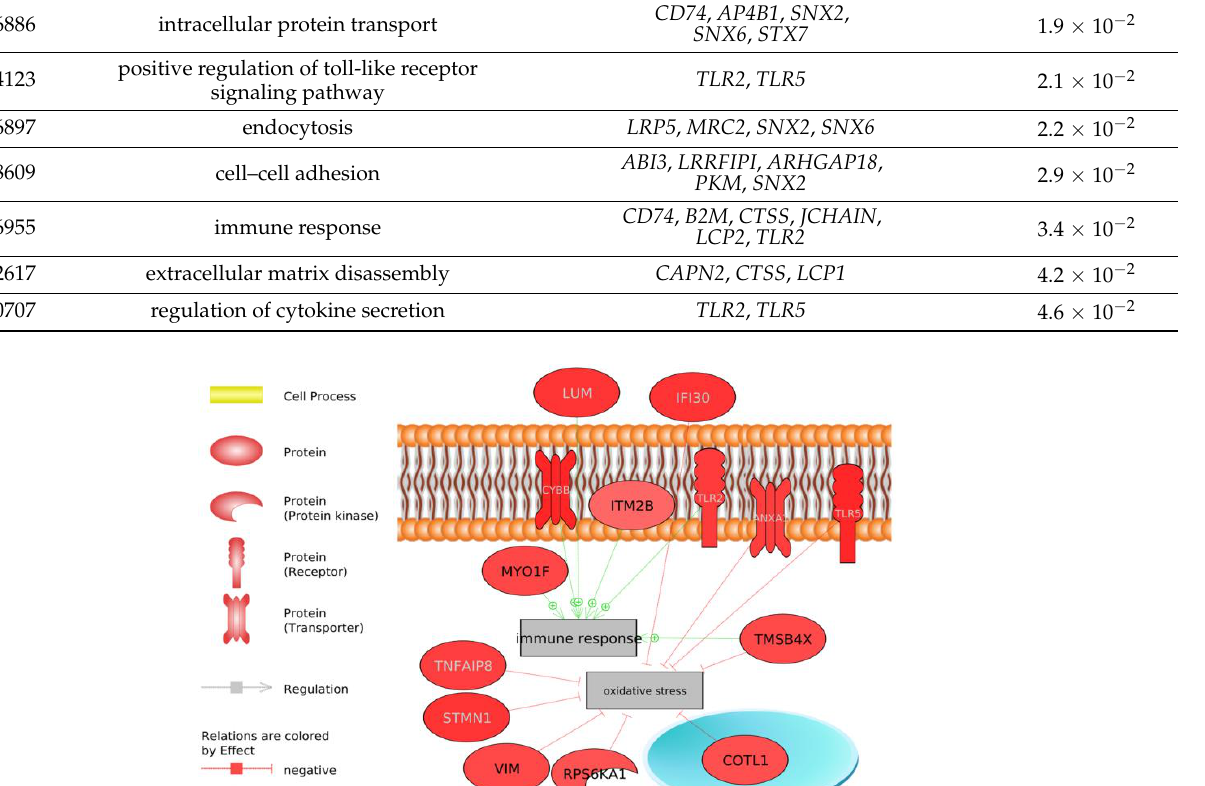
Figure 4. DEGs involved in the immune response and oxidative stress with an effect known using Pathway Studio software. Highlighted in red are genes over-expressed in the LRFI group and in blue are under-expressed genes in the LRFI group. Green arrows indicate a known positive regula- tion effect, red arrows indicate a known negative regulation effect and gray arrows indicate an un- known regulation effect.